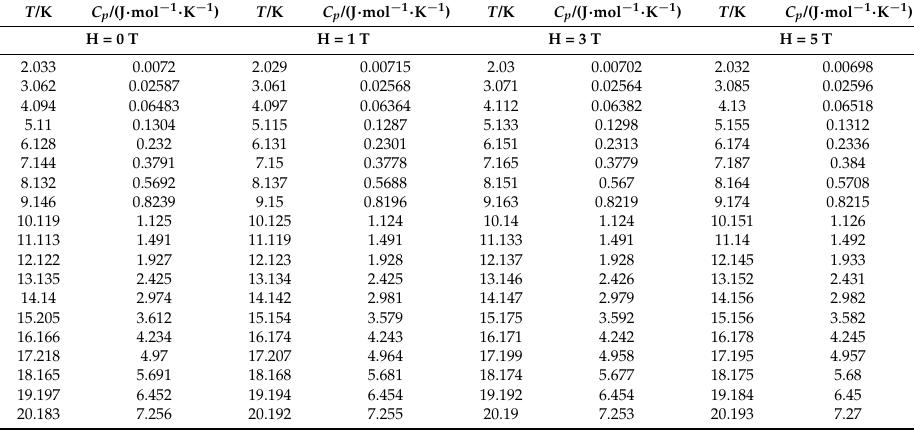
Figure 3. Low temperature C p versus T and C p versus ln T of D - and L -valine at zero-field. Table 1. Magnetic-field dependence of heat capacity of D -valine (11.30 mg) at 2 – 20 K. T /K